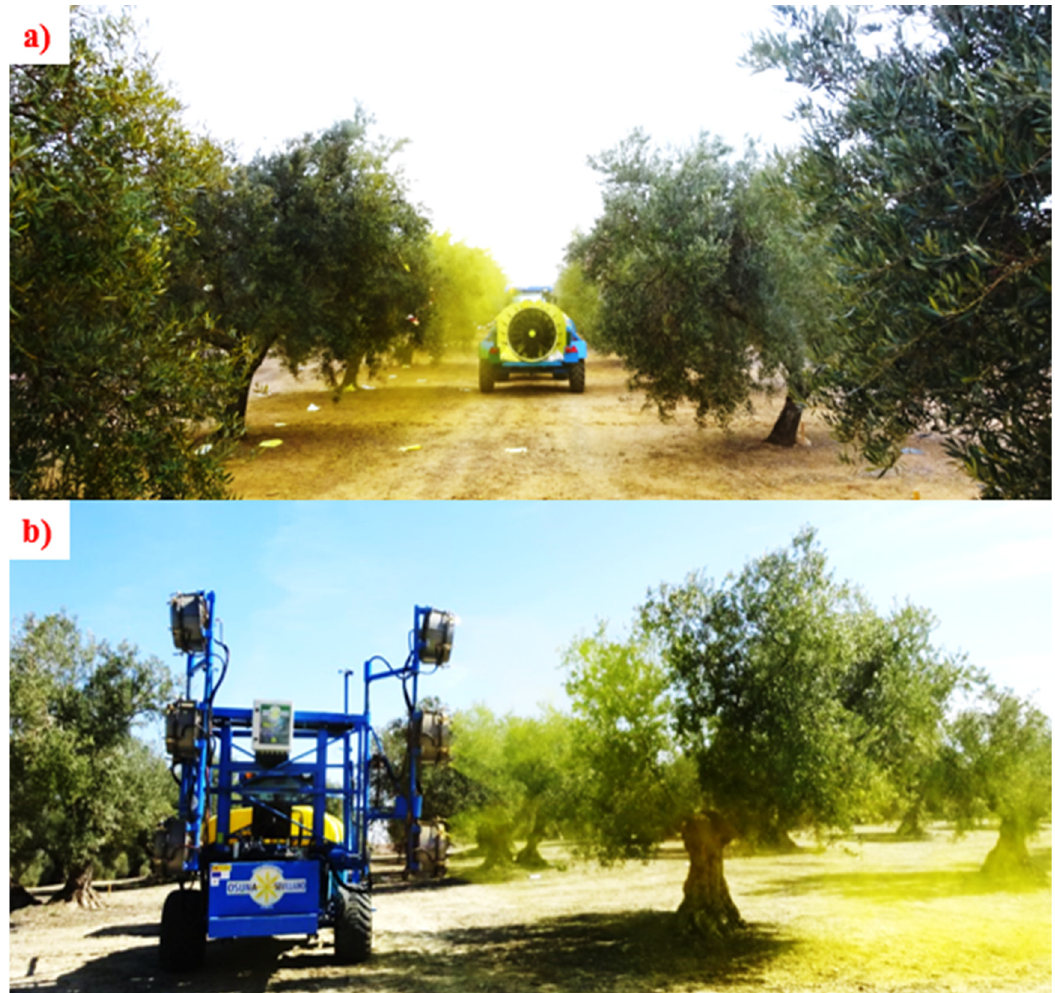
Figure 1. Sprayers treating the two studied olive orchards: ( a ) Intensive; ( b ) Traditional.